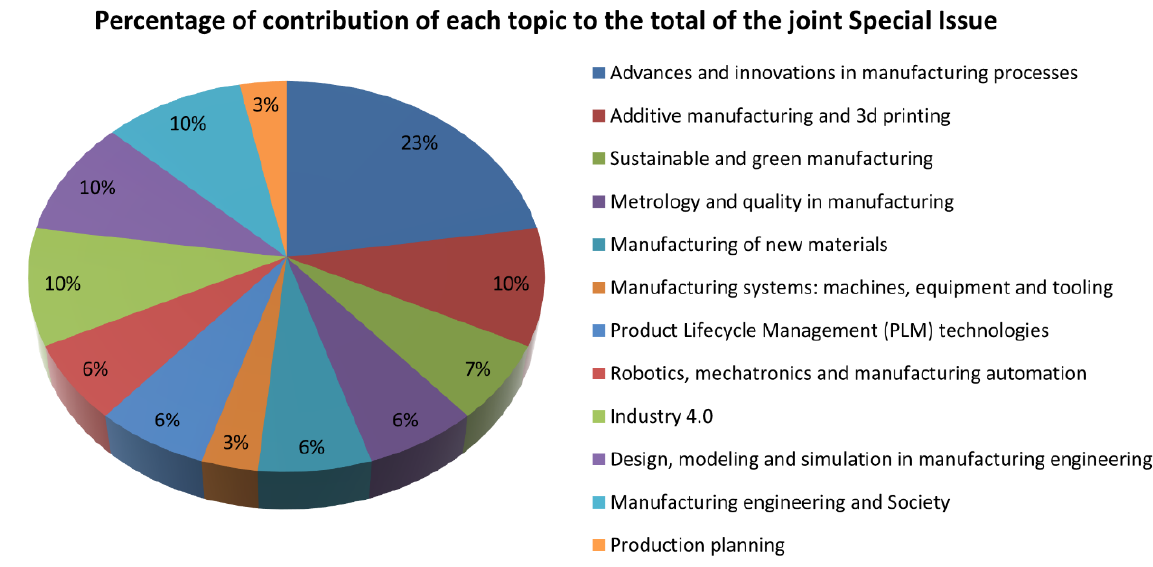
Figure 1. Percentage of contribution of each topic to the total of the joint Special Issue.